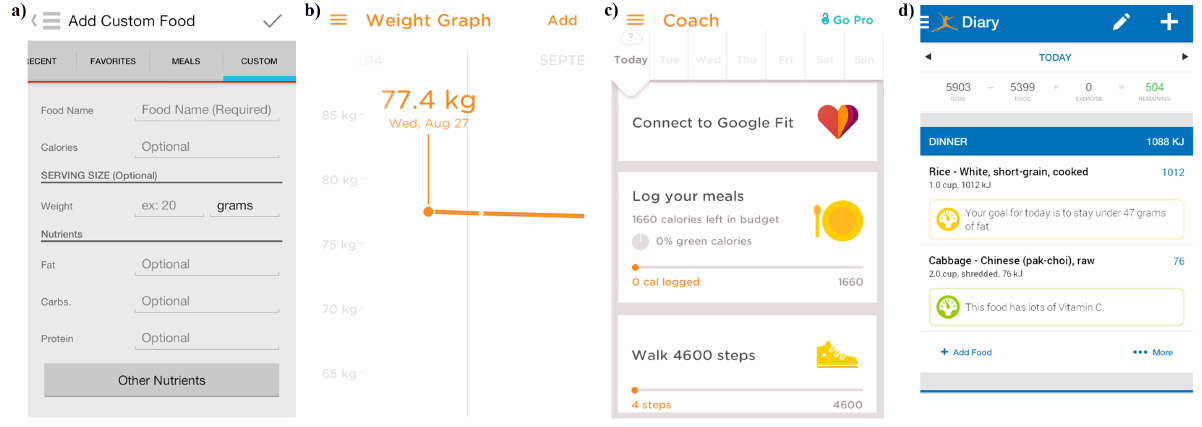
Figure 6. Screenshots of technology-enhanced features present in smartphone apps: (a) modifiable food database (from Calorie Counter by FatSecret), (b) weight progress charts (from Noom Weight Loss Coach by Noom, Inc), (c) built-in physical activity tracking device (eg, pedometer, accelerometer, or connection to other activity monitoring apps) (from Noom Weight Loss Coach by Noom, Inc), and (d) flags for lapses in dietary goal adherence (from MyFitnessPal by MyFitnessPal,